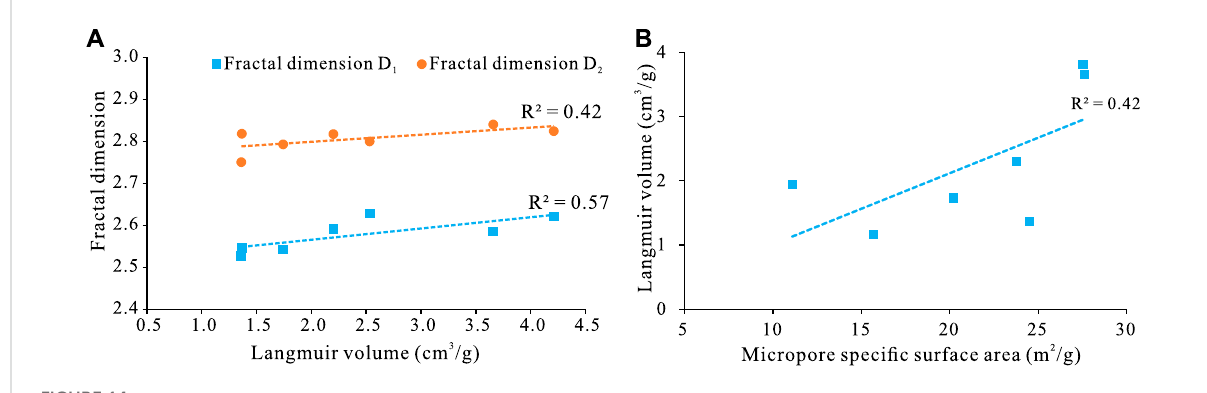
FIGURE 14 (A) Relationships between the V L and fractal dimensions (D1 and D2) and (B) relationships between the V L and micropore SSA.